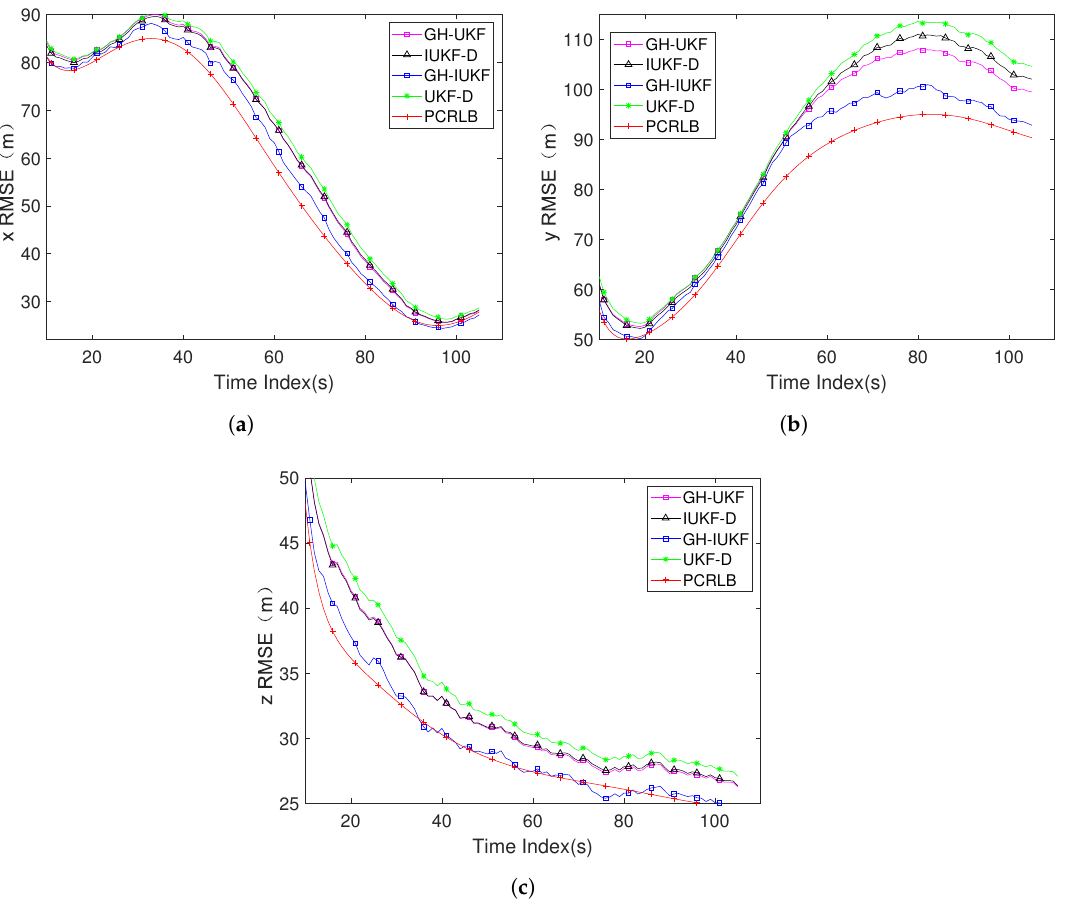
Figure 7. The RMSE components of target position and velocity: ( a ) RMSE of the position in x axis; ( b ) RMSE of the position in y axis; ( c ) RMSE of the position in z axis.